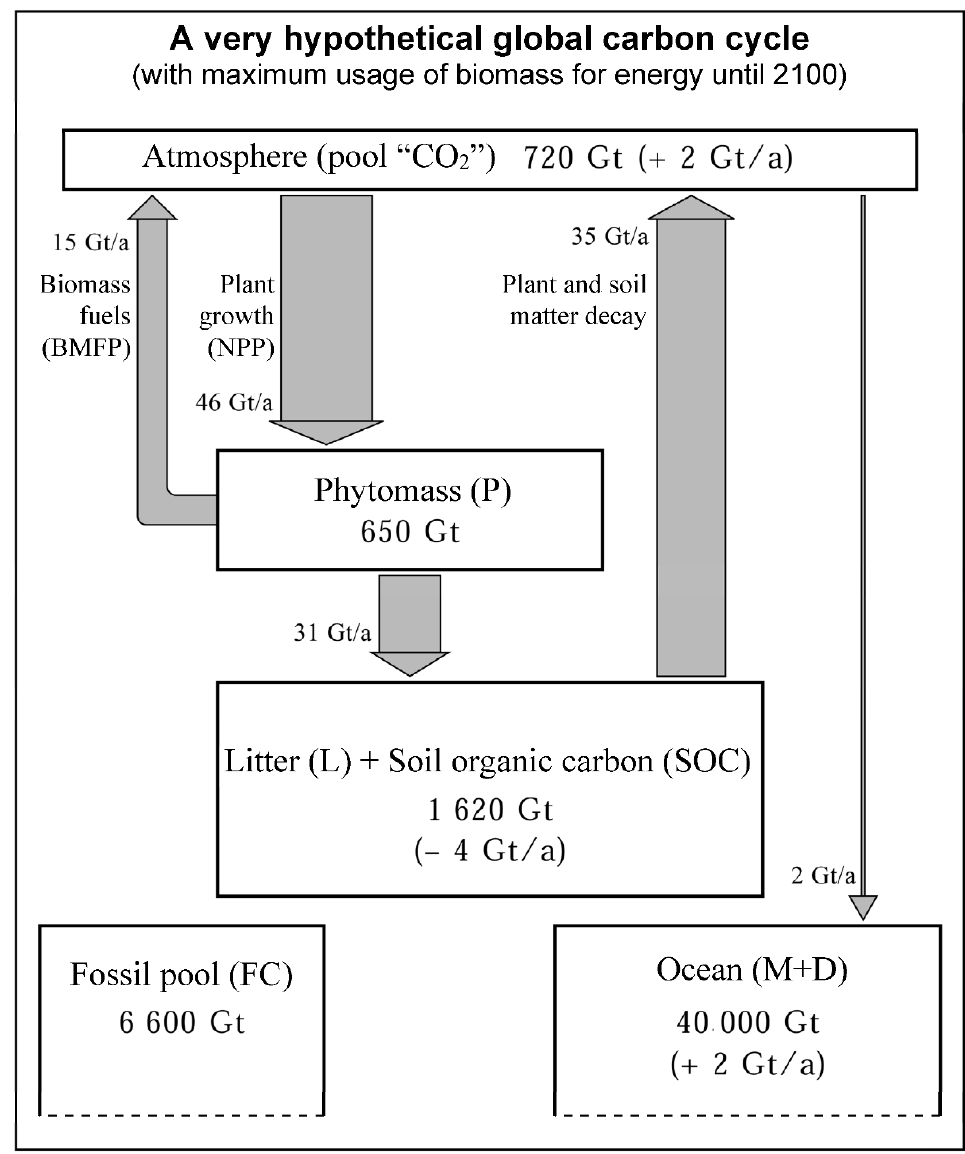
Figure 7. Overview of the carbon cycle when changed by maximum global energy use of biomass. The letters defining the carbon pools and fluxes are identical to those in Figure